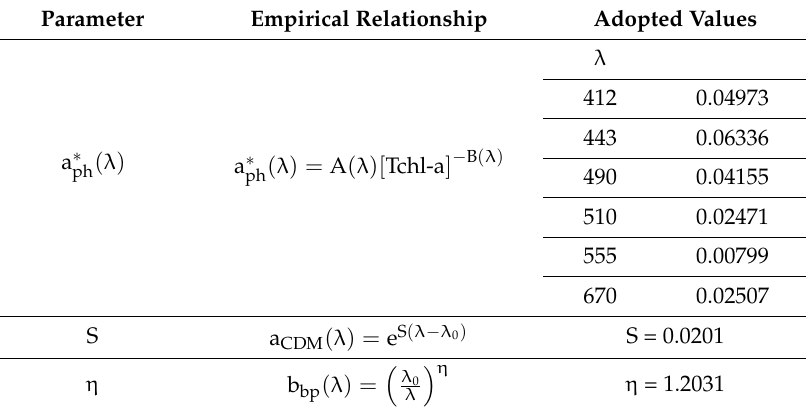
Table 5. Empirical relationship of the non-water components of absorption and scattering selected for the locale scale configuration (GSM-BICW).